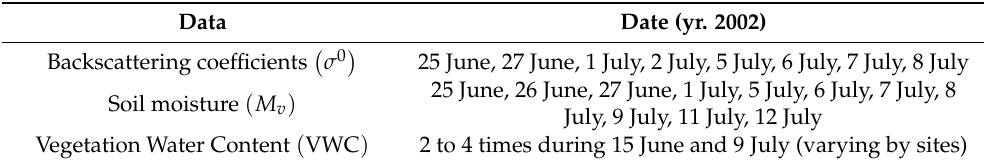
Table 1. Sampling dates of backscattering coefficients content ( VWC ) ; highlight for overlapping